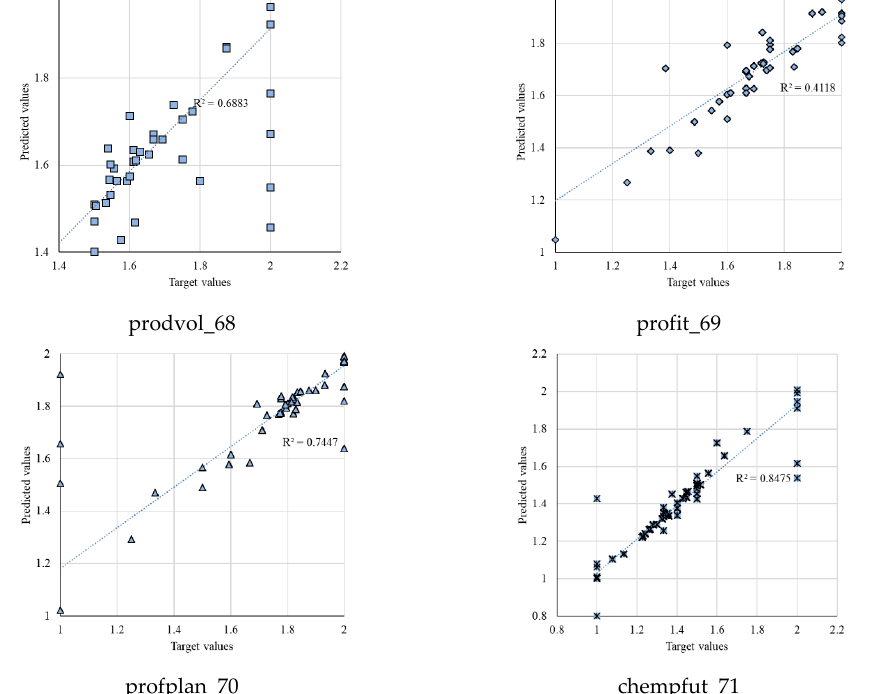
Figure 7. Plot diagrams for the effects of skills requirements and skill matches on output values of firm performance. According to characteristics connected to employee voice, the mean value of linear- ity for predicting employee wellbeing is roughly 87%, as shown in Figure 8. Figure 9 il- lustrates how factors related to employee voice affect firm performance.